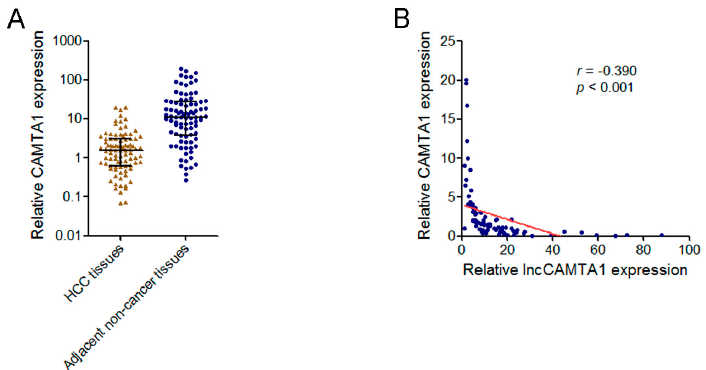
Figure 7. lncCAMTA1 expression is negatively correlated with CAMTA1 in HCC tissues. ( A ) CAMTA1 expression in HCC tissues and adjacent non-cancerous hepatic tissues. Data are shown as median with interquartile range. n = 90, p < 0.001 by Wilcoxon signed-rank test; ( B ) lncCAMTA1 and CAMTA1 expression levels were negatively correlated in HCC tissues. r = − 0.390, p < 0.001 by Pearson correlation analysis.